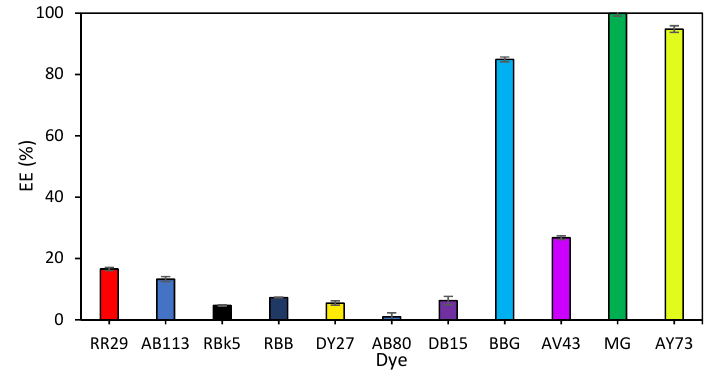
Figure 2. EE of T:D (1:1).